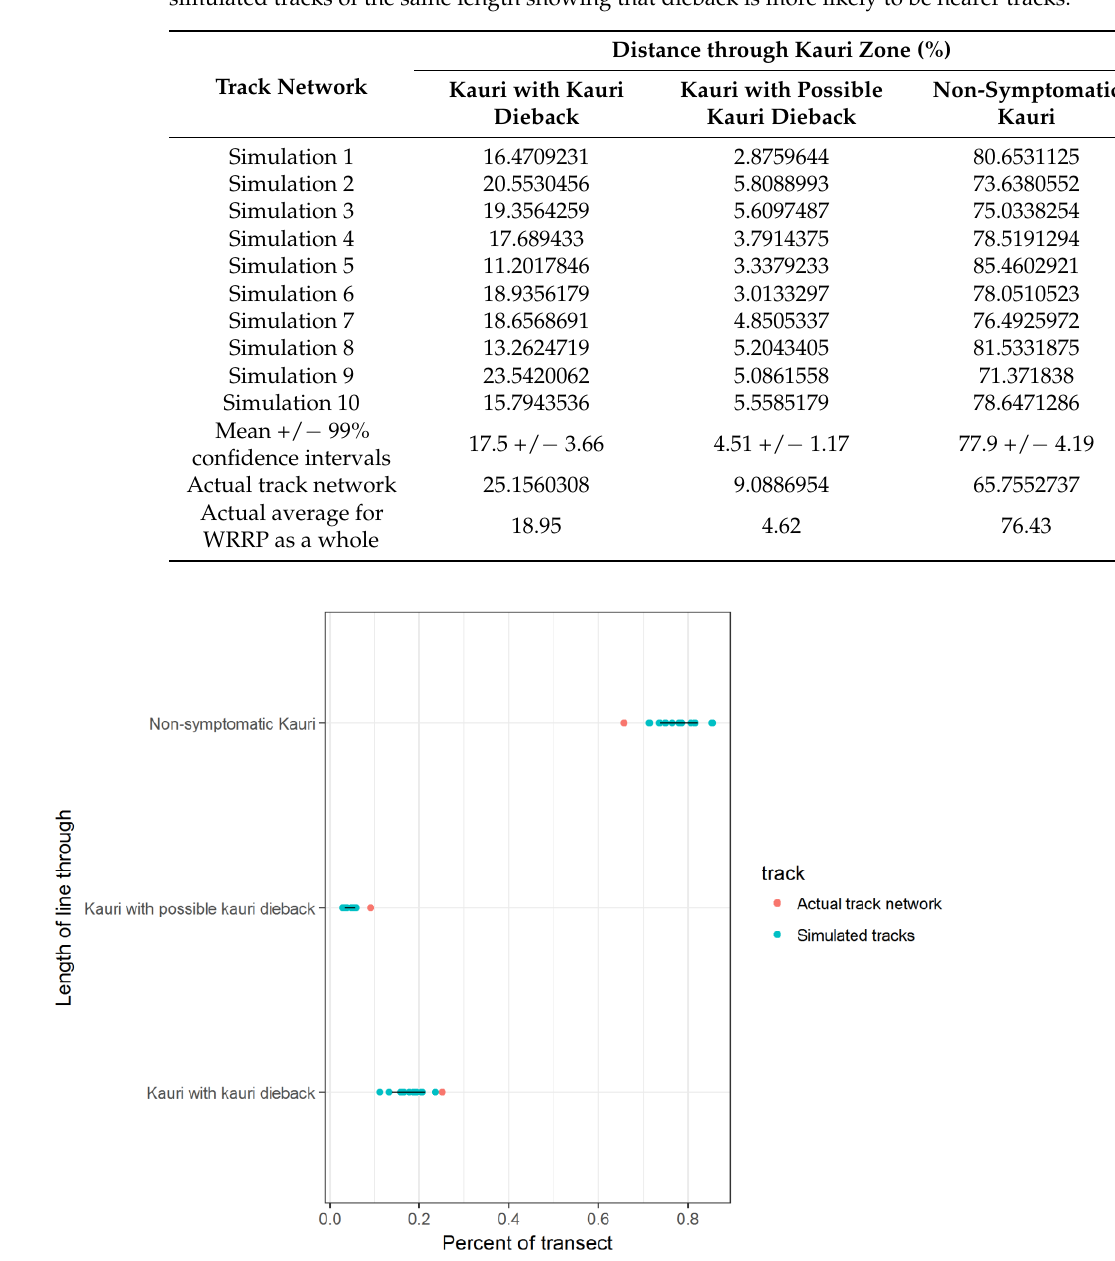
Figure 6. Comparison of dieback along tracks (percentage) between actual data from this survey and simulated tracks of the same length showing dieback is more likely to be nearer tracks. Black lines are the 99% CIs from the simulated tracks.